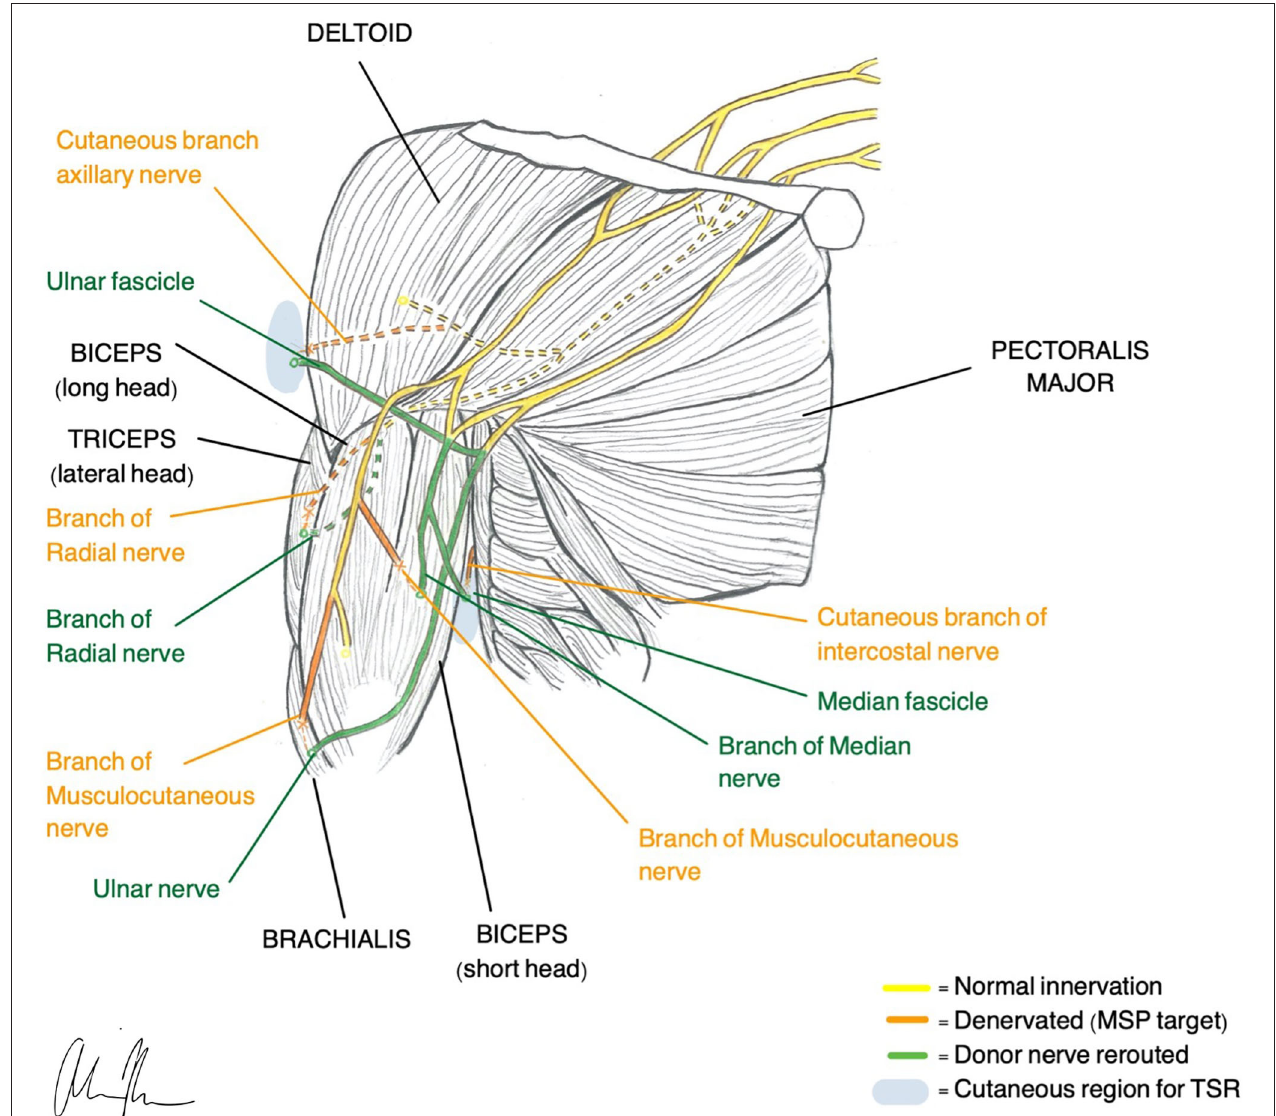
FIGURE 1 | Illustration of TMR (Gart et al., 2015) and TSR (Hebert et al., 2014) construction in a transhumeral